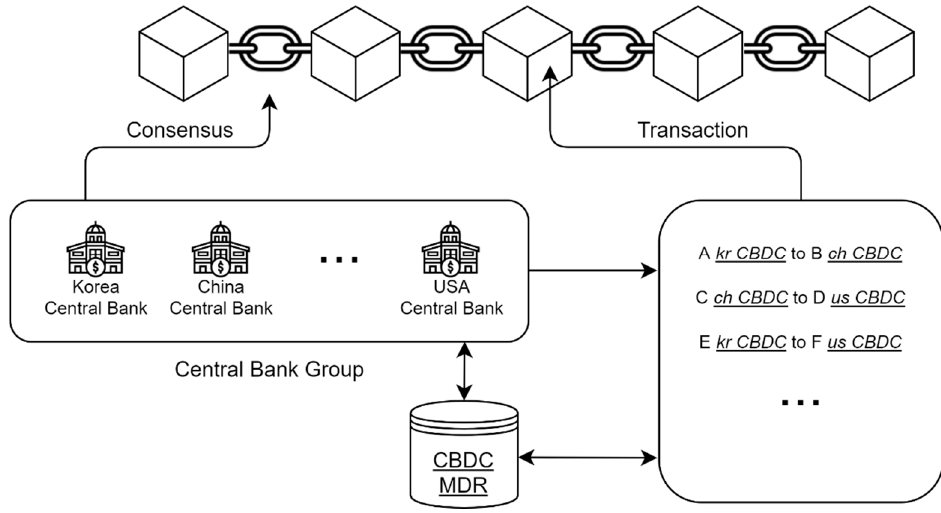
Figure 6. MDR-based CBDC blockchain model.